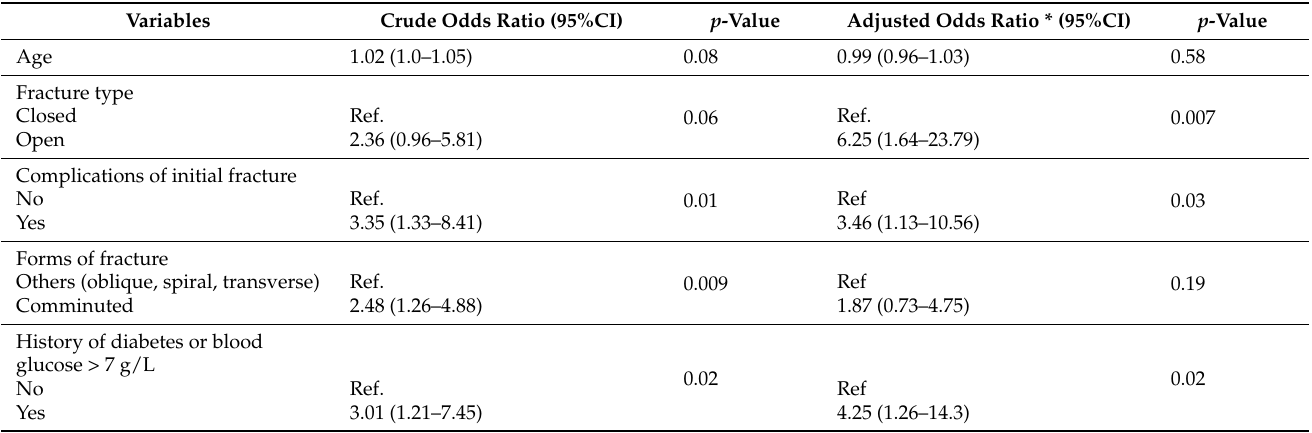
Table 3. Bivariate and multivariate logistic regression analyses of association between socio- demographics and variables related to trauma with